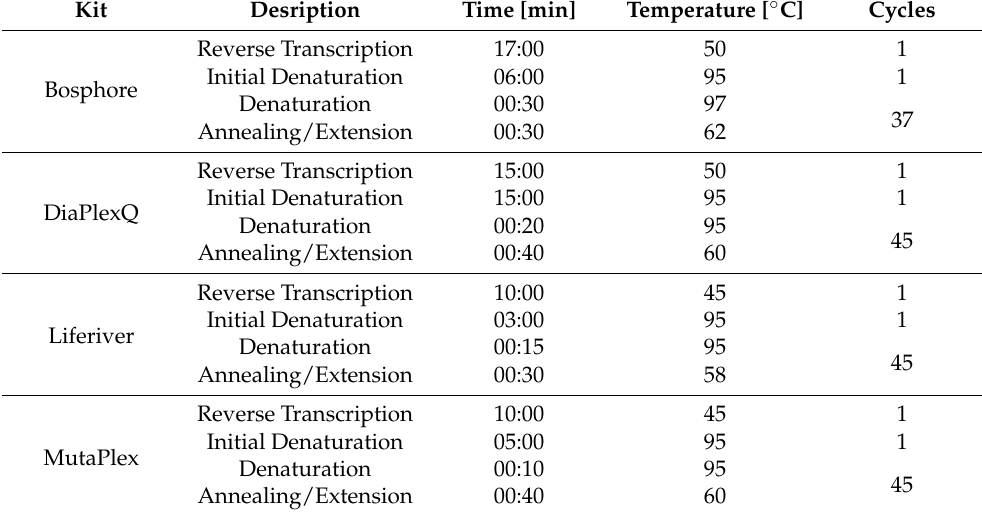
Table 2. RT-qPCR thermal